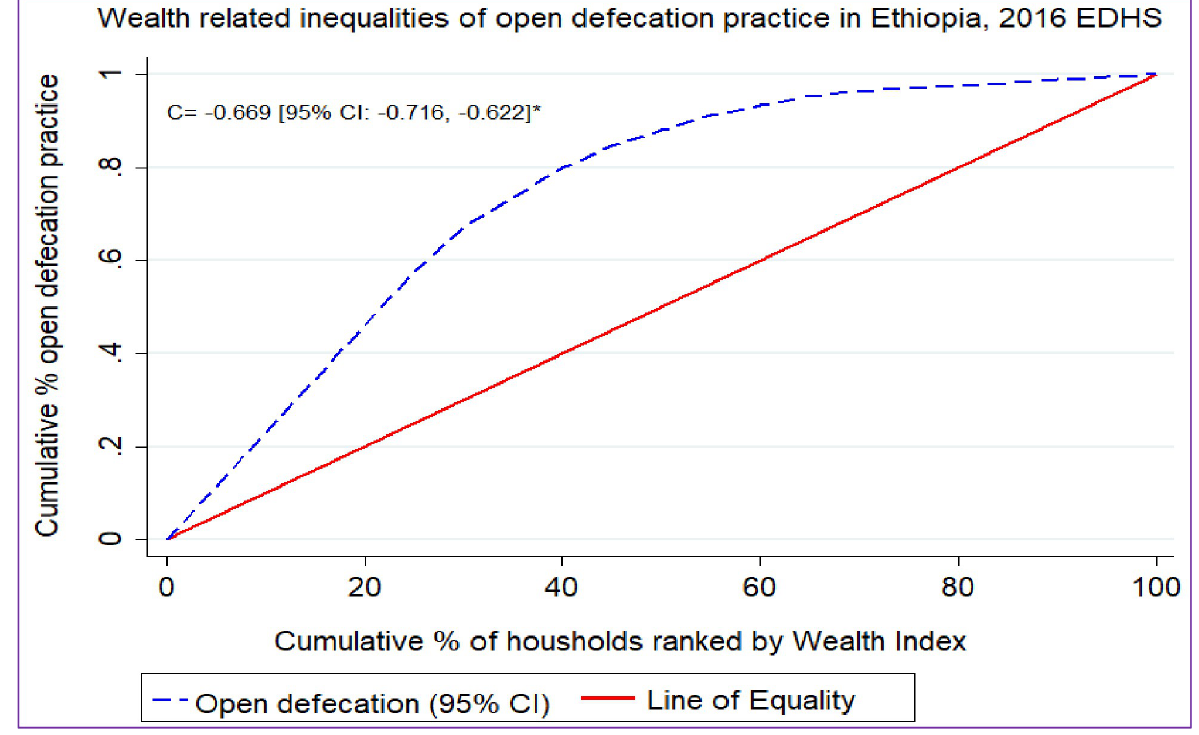
Fig 3. Wealth-related inequality of open defecation in Ethiopia, EDHS